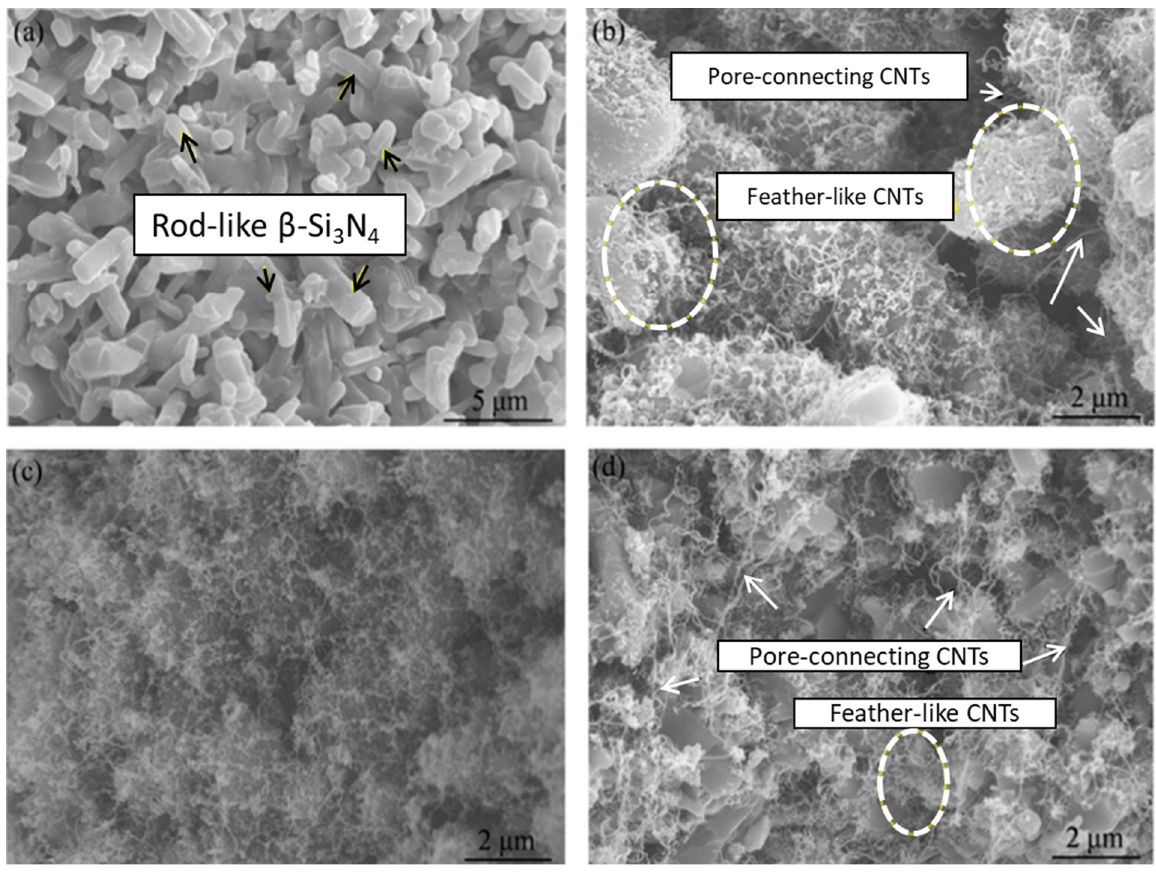
Figure 8. Scanning electron microscope (SEM) images and fracture surface images of ( a ) neat Si 3 N 4 , ( b ) 2 wt.% CoAc, ( c ) 4 wt.% CoAc, and ( d ) 10 wt.% CoAc. The resulting CNTs contents are 0, 1.49, 1.97, and 2.70 wt.%, respectively. (Adapted with permission from ref. [102]. Copyright 2015 Elsevier.)